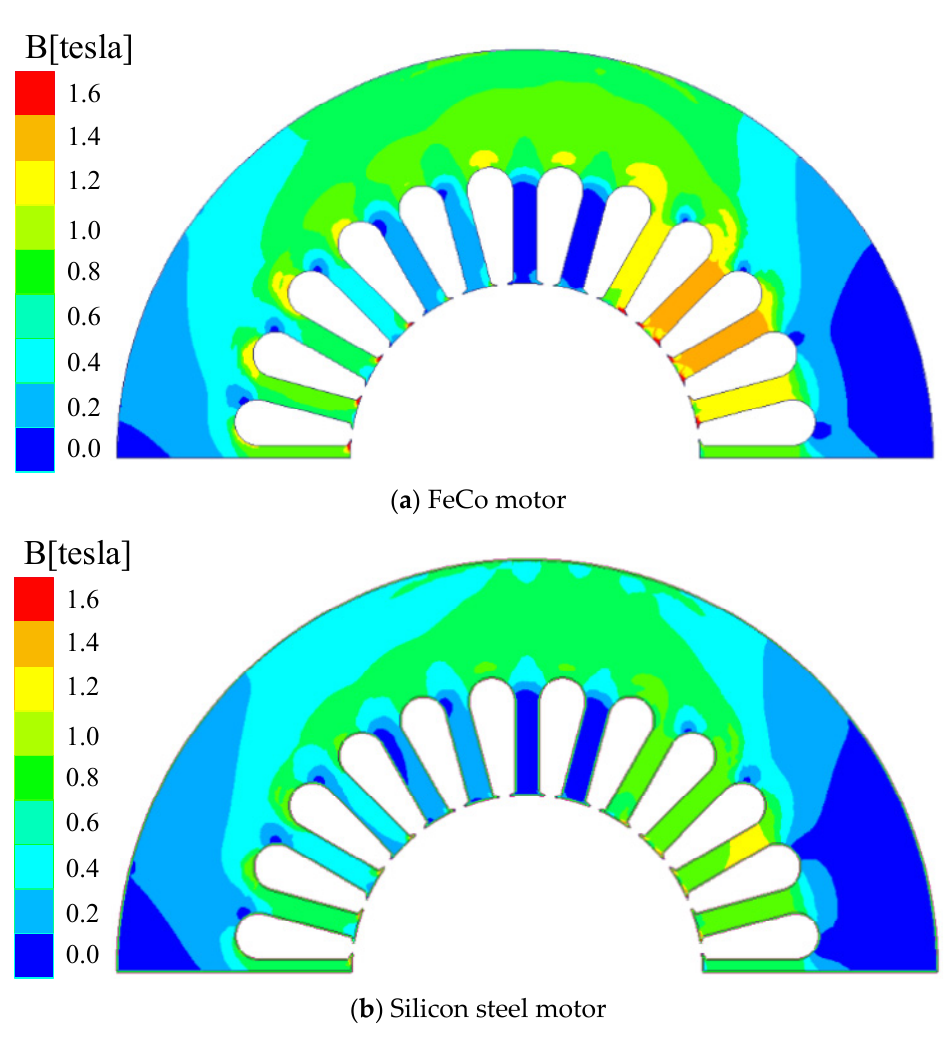
Figure 15. Comparison of magnetic density at 0.2 times the load. It can be seen from Figures 15 and 16 that since the lamination coefficient of the FeCo motor iron core is lower than that of the silicon steel motor iron core, the magnetic density of the FeCo motor stator core is much higher than that of the silicon steel motor at 0.2 times the load. Furthermore, the saturation magnetic density of FeCo motor iron core is lower than that of silicon steel motor (Figure 3); therefore, with the increase of load rate, the saturation degree of FeCo motor stator iron core is much higher than that of silicon steel motor, and the FeCo motor winding magnetomotive force waveform distortion is more serious, due to The resulting increase of p stator2 and p pm2 with the increase of load rate is larger than that of silicon steel motor, which indirectly causes the FeCo motor’s efficiency advantage to become smaller and smaller with the increase of load.